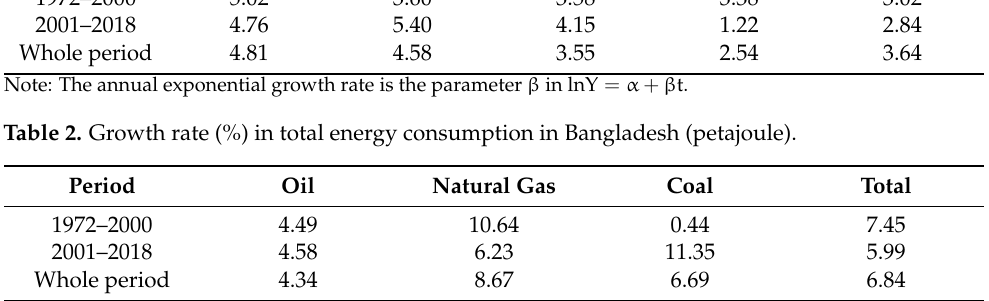
Table 1. Growth rate (%) in per capita energy consumption (tonne of oil equivalent). Period